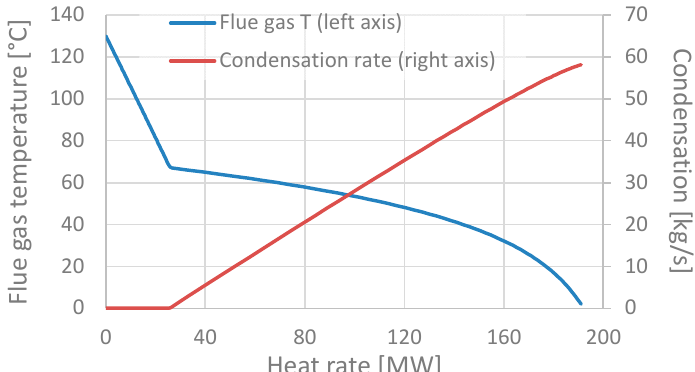
Figure 1. Relationship between temperature and recovered heat in the dry and condensing regimes.